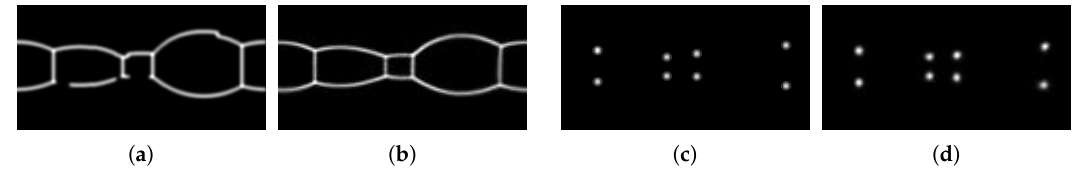
Figure 7. Results of CFL using a synthetic image from a 4-wall environment. ( a ): Edges ground truth; ( b ): Edges output from CFL; ( c ): Corners ground truth; ( d ): Corners output from CFL.